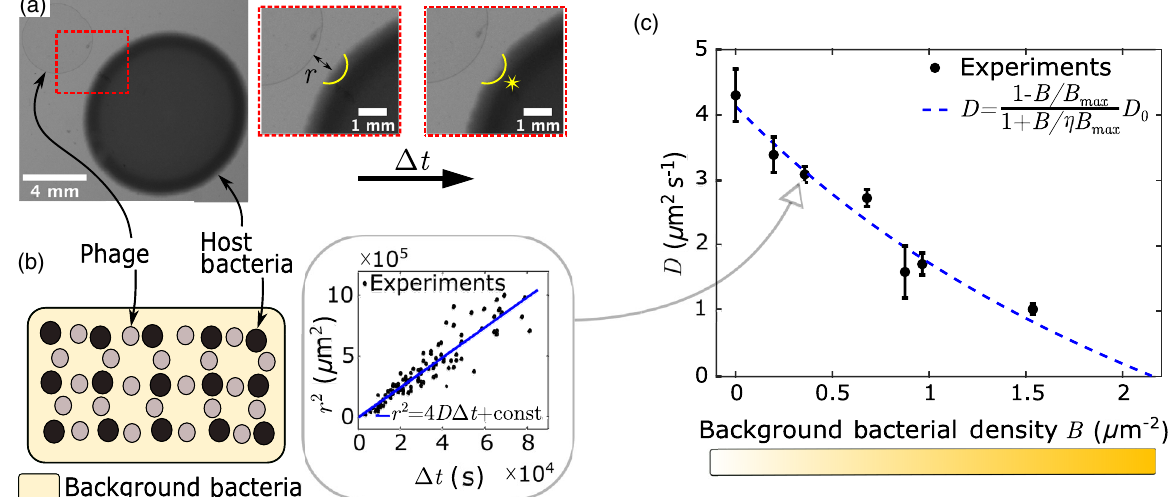
FIG. 1. Experiments show how rate of phage diffusion is reduced by surrounding bacteria. (a) The basis of the experimental setup consisting of a droplet of phage and host bacteria separated by a distance r . After time Δ t , a plaque begins to form in the host bacterial droplet (starred region). (b) The full experimental setup consisting of many phage-host droplet pairs on top of a lawn of phage-resistant bacteria of variable density. The presence of chloramphenicol in the plate media ensures that the background bacterial density is constant over the course of the experiment (see Sec. VI). An example plot of r 2 against Δ t data, with linear fit, for a resistant bacteria density of 0 . 36 μ m − 2 is shown. (c) The diffusion coefficient obtained as a function of the resistant bacteria density [i.e., for several instances shown in (b)] fit with Fricke ’ s law [Eq.